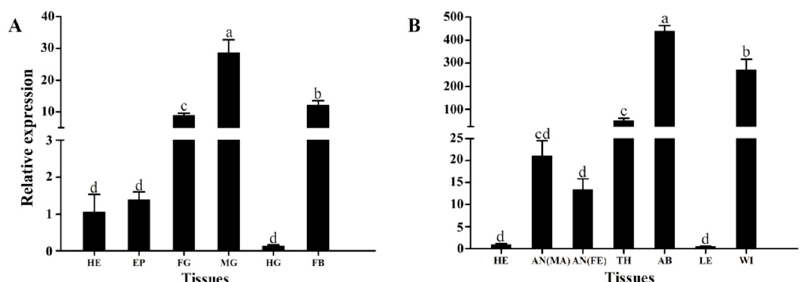
Figure 3. Relative expression levels of HvATG8 in different tissues of larvae and adults (tissues of 40 fifth-instar larvae were dissected). (A) Relative expression in larval tissues: HE, head; EP, epidermis; FG, foregut; MG, midgut; HG, hindgut; and FB, fat body. (B) Relative expression in adult tissues: HE, head; AN, antenna; TH, thorax; AB, abdomen; LE, leg; and WI, wing. Internal reference gene was α - Tubulin. Error bars represent mean ± standard error of three biological replicates. Different letters above error bars mean significant differences ( p < 0.05), based on one-way analysis of variance (ANOVA) followed by Tukey’s test.